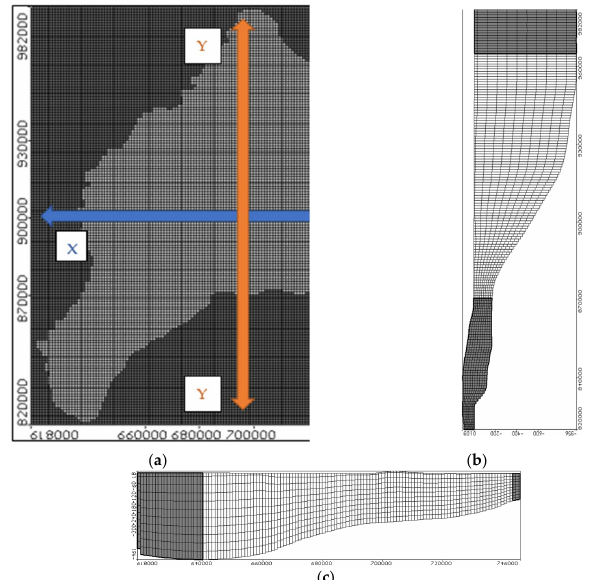
Figure 3. Model geometry of the ENDA: ( a ) model domain ( b ) cross-section in the X-direction and ( c ) cross section in the Y-direction. The aquifer is divided into eleven layers; the top layer is the clay cap with variable thickness starts from 20 m in the south and progressively increases to 50 m in the north. The soil type of the aquifer was represented by dividing the layers from two to eleven into equal thicknesses. Fine sand was allotted to layers from two through five. Layers (six to nine) were dedicated to coarse sand, whereas layers ten to eleven were designated to graded sand and gravel. Figure 3b and c show the vertical and horizontal sections in the ENDA.